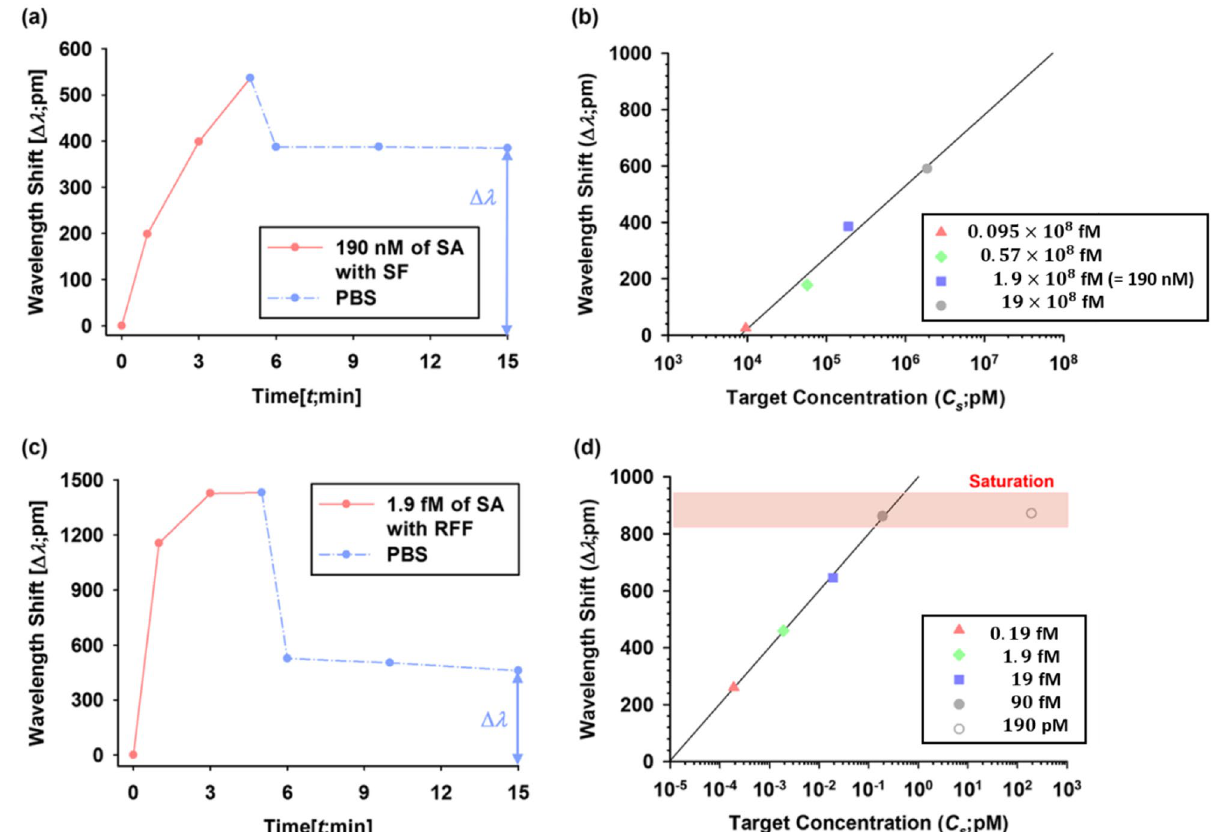
Figure 5. Binding curves of; ( a ) wavelength shifts of 190 nM Streptavidin solution injected by the Single Flow (SF) method, ( b ) the resonance shift values by SF method at 15 min (10 min after PBS washing) plotted against the different concentration of Streptavidin solution ranging from 9.5 nM (= 0.095 × 10 8 (= 19 × 10 fM) (R 2 = 0.9838), ( c ) wavelength shifts of 1.9 fM Streptavidin solution injected by the RFF method and ( d ) the resonance shift values by RFF method at 15 min (10 min after PBS washing) plotted against the various concentration of Streptavidin solution ranging from 0.19 fM to 190 pM (R 2 = 0.9992). For ( a ) and ( c ) the dotted blue lines are plotting wavelength shift after PBS washing. This process is required for ensuring single layer molecule binding on the sensor